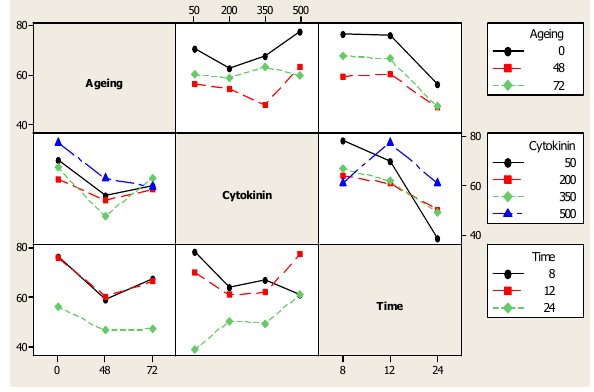
Fig. 2. Interaction plot of coefficient velocity of seed germination under hormone seed priming and ageing treatments